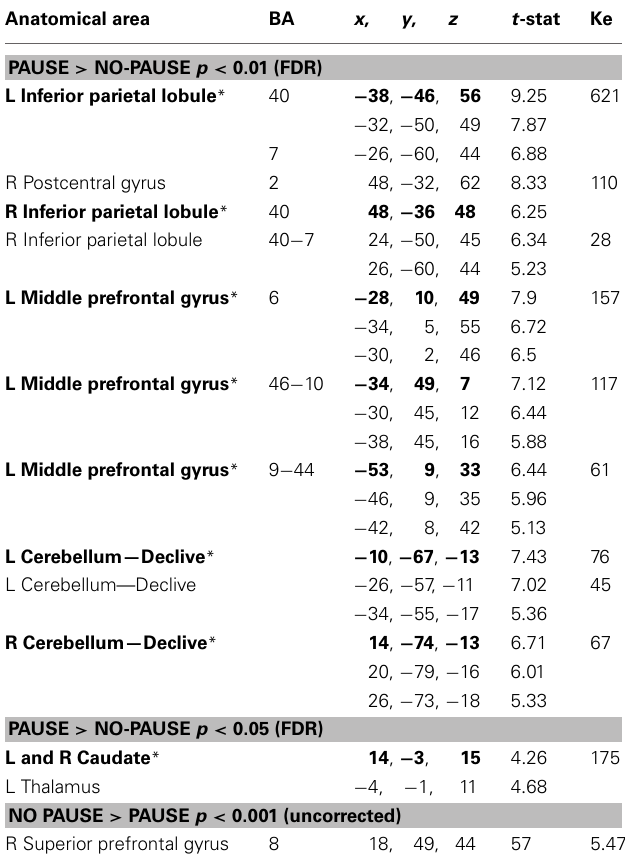
Table 2 | Specification of regions with significant activation in the Pause vs. No-pause contrast (P > N) at p < 0 . 01 (FDR) and p < 0 .